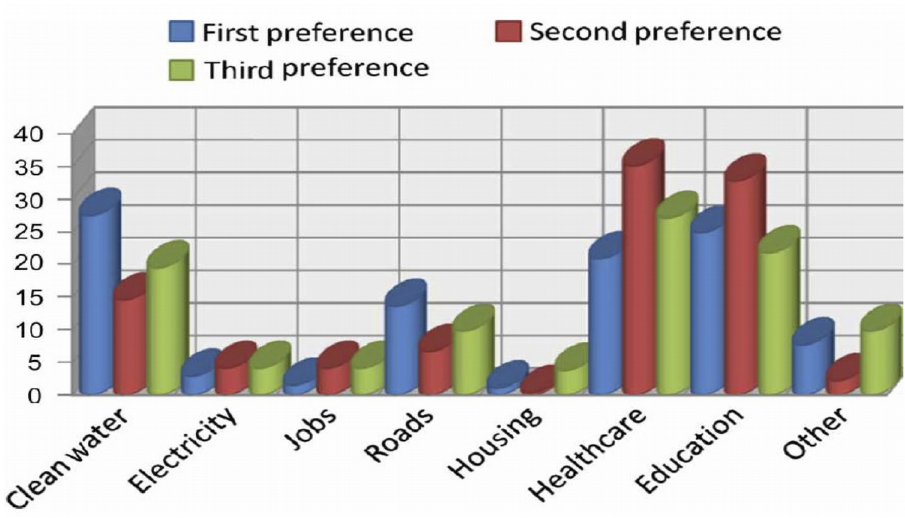
Figure 2. Local preferences for peace dividends in the